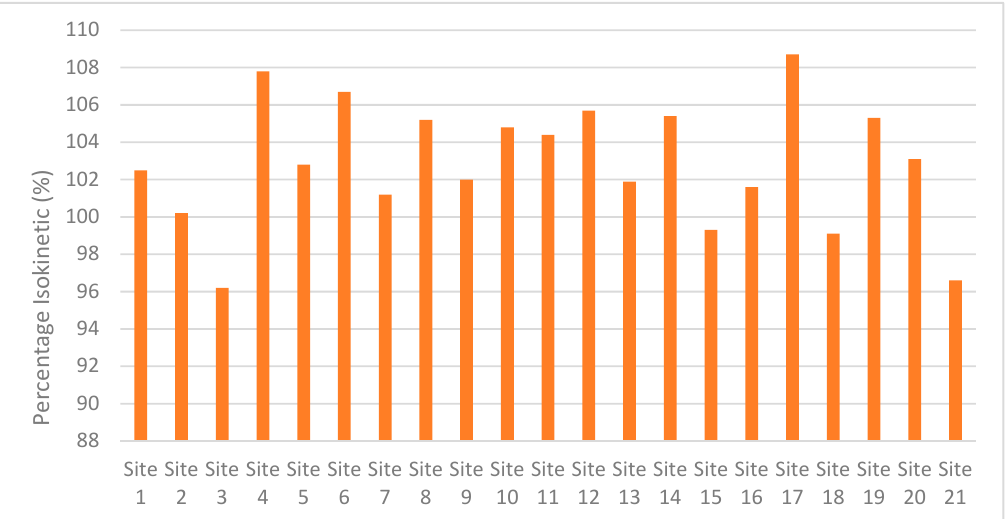
Figure 3. Isokinetic percentage for each sample.